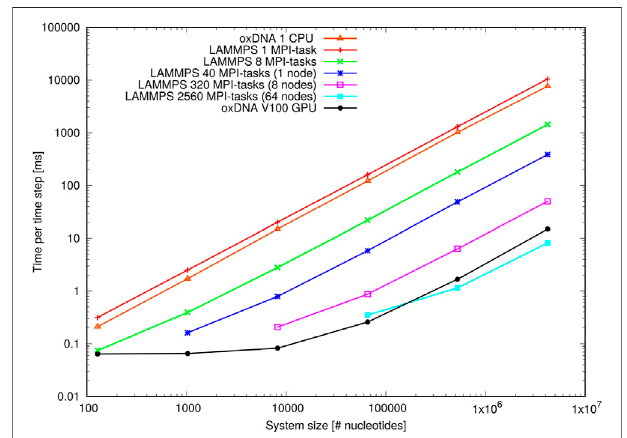
FIGURE 12 | Performance of the oligomer benchmark as time per time step for various system sizes: Shown are results of the oxDNA standalone code on a single CPU and NVIDIA V100 GPU and of the LAMMPS implementation of the oxDNA2 model at different CPU counts.